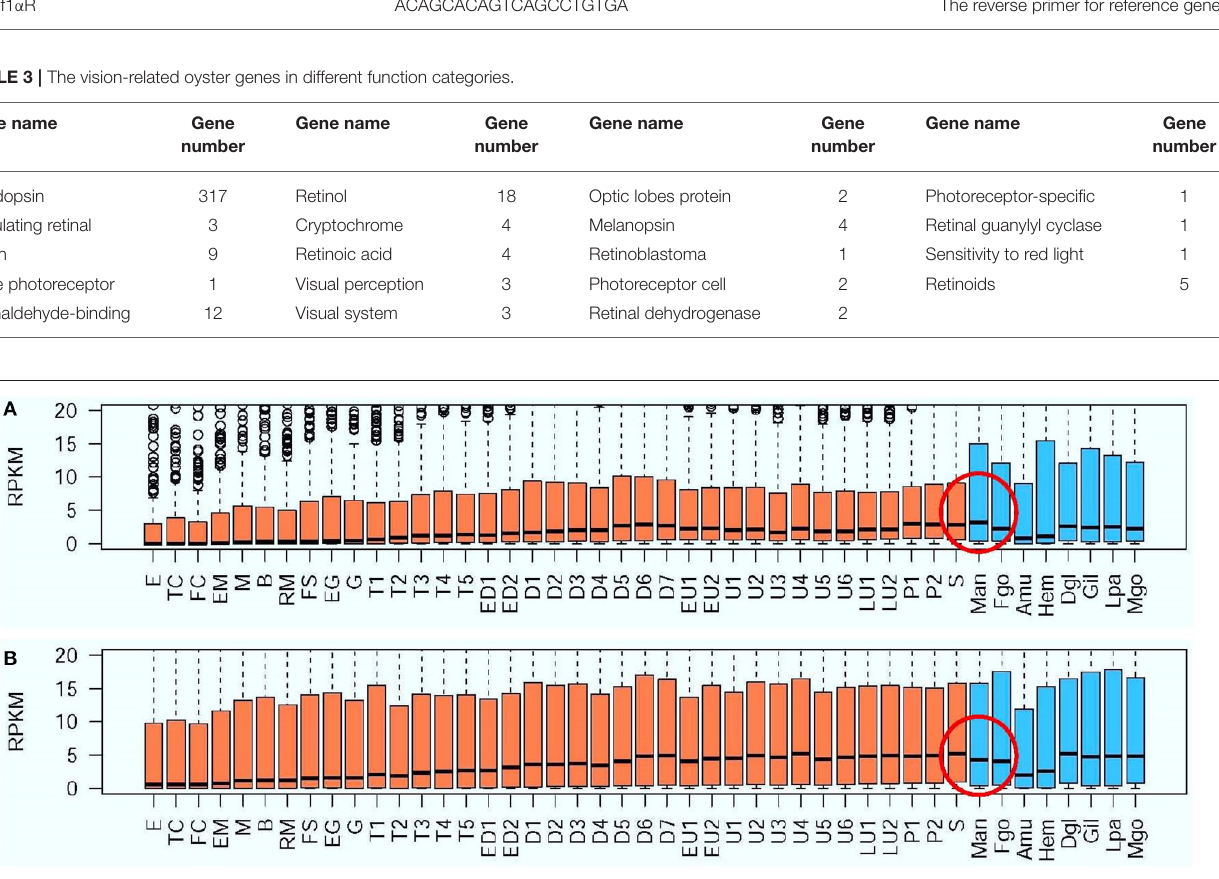
FIGURE 1 | Expression pattern of vision-related genes (A) and all other oyster genes (B) at different developmental stages and in different organs. Y-axis denotes expression as an RPKM value, while the X-axis denotes the 37 development stages (sienna bars) and the eight organs of adult oyster (steel blue bars).